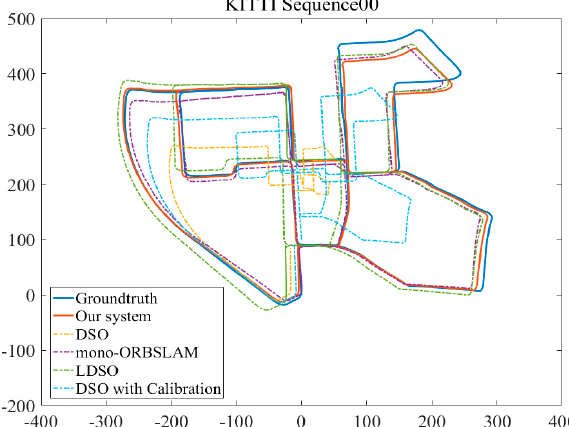
Figure 11. The experimental trajectories results of our system, DSO, LDSO and the enhanced DSO which was integrated with the algorithms proposed in [12] and [14] along the x -axis and z -axis of the KITTI dataset sequences 00.